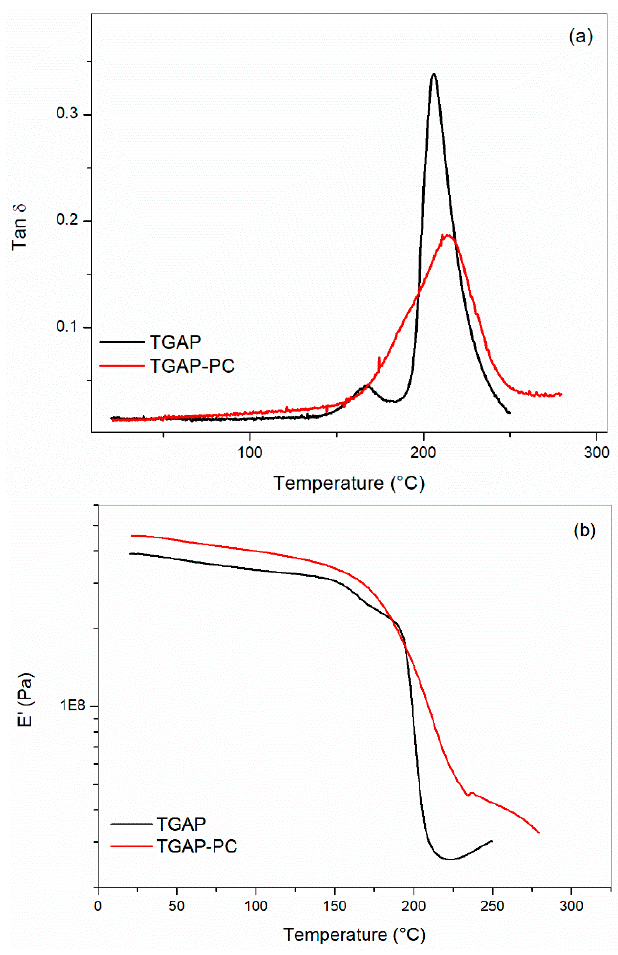
Figure 4. DMA comparison for the neat matrixes before (TGAP) and after post-curing (TGAP-PC): ( a ) tan δ versus temperature; and ( b ) Storage modulus (E’) versus temperature.